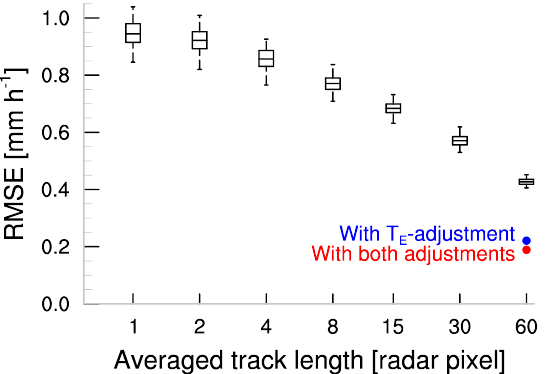
Figure 6. RMSE (mm h − 1 ) shown as a function of averaging length in radar pixel units. Black boxes (interquartile spread, median) and whiskers (minimum, maximum) mark uncertainty obtained from resampling of 100 realizations of unadjusted R T , while the blue dot marks the RMSE of R ∗ dot of R ∗∗ , T